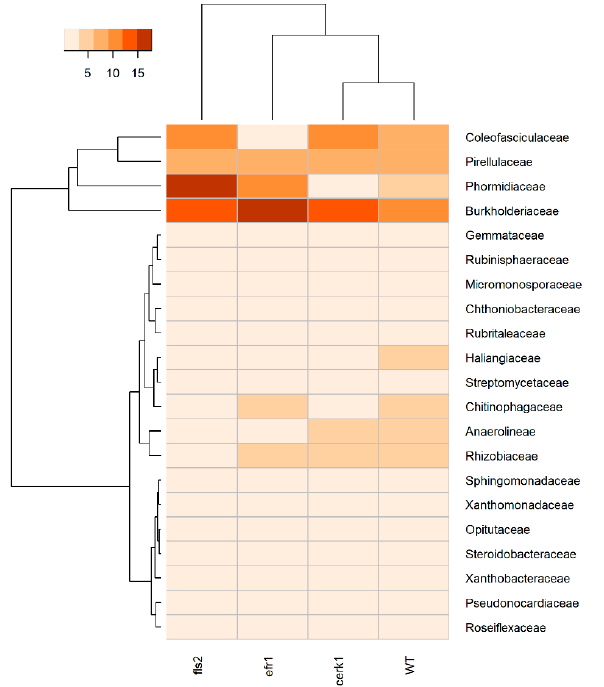
Figure 2. Heatmap displaying bacterial relative abundance at the family level for three different Arabidopsis PAMP mutants ( cerk1 , efr1 , and fls2 ) and the wild-type (WT; Col-0) grown in native soil from the Red River Farm (OK, USA). Heatmap is color-coded based on relative abundance values. Less enriched samples are shown in light orange/pink while dark orange/red represents highly enriched samples. Samples with similar microbial profiles were recursively grouped together in branches of a dendrogram. Families with <1% were not included. Hierarchical clustering of distances using taxonomy relative abundance data were generated using Euclidean distance calculation to obtain a matrix and dendrogram construction using